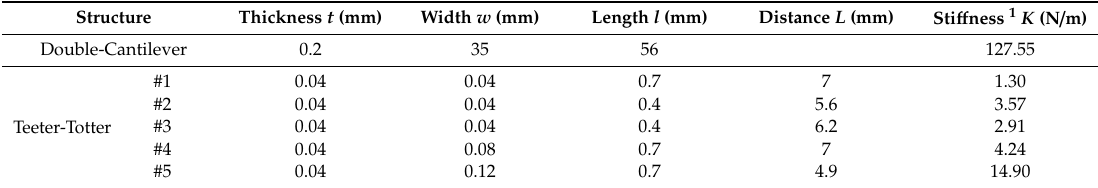
Figure 3. Schematic of sensing structures. ( a , b ) Structure for the normal load detection. ( a ) A 3D model of the double-(leaf-)cantilever pair; ( b ) a side view sketch of the di ff erential capacitor configuration. ( c , d ) Structure for the lateral load detection. ( c ) A 3D model of the teeter-totter structure; ( d ) a side view sketch of the di ff erential capacitor configuration. Table 1. Mechanical characteristics of the sensing structures.